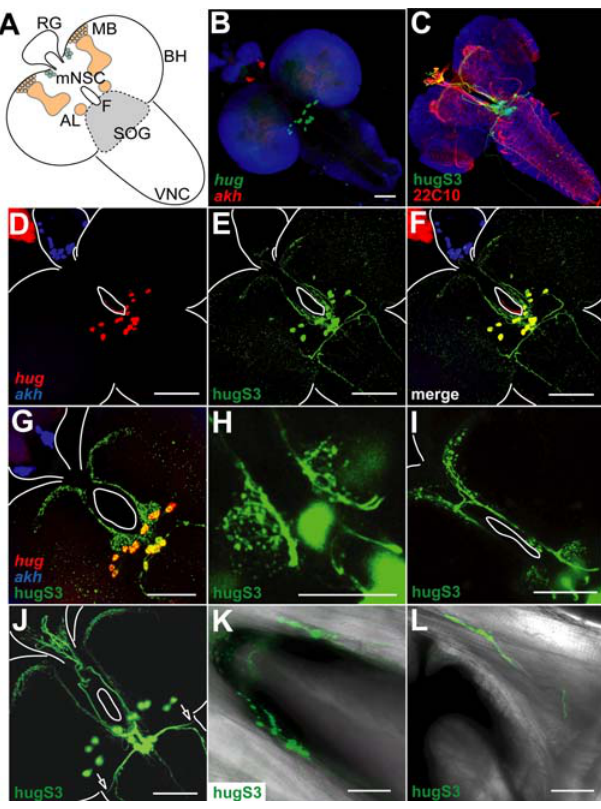
Figure 2. Neuroanatomical Analysis of hug Expression and Neuronal Projection Patterns in Larvae (A) A schematic drawing of the Drosophila larval CNS, showing the relative positions of the two brain hemispheres (BH) and the VNC, with the neuroendocrine ring gland (RG) located dorsoanterior to the CNS. The esophagus goes through the brain, and we have termed the hole through which the esophagus passes as the foramen (F). Positions of the SOG, the larval antennal lobes (AL), the mushroom bodies (MB), and the median neurosecretory cells (mNSC) are depicted. (B) hug expression (shown in green) is restricted to the SOG. adipokinetic hormone ( akh , shown in red) serves as a ring gland marker; the CNS is false-colored in blue. (C) Detection of marker gene expression under hug promoter-Gal4 (hugS3) construct (shown in green) labels hug cell bodies and neuronal projections relative to the neuropil (22C10, shown in red) and nuclei of post-mitotic neurons (elav, shown in blue). (D–F) The endogenous hug expression pattern (shown in red in [D]) is reproduced by the hugS3 expression pattern (shown in [E]). Note double-positive cell bodies in (F). akh serves as ring gland marker; CNS, ring gland, and foramen are outlined. (G and H) Immunofluorescent (G) as well as direct (H) detection of GFP expressed under the hug promoter-Ga14 construct reveals putative hug dendrites dorsoanterior of the hug cell bodies, where spherical structures are innervated. The hug cell bodies in the depicted blow-up of SOG region are out of focus in (H). (I) hug axons innervating the protocerebrum cross the midline, showing ipsilateral and contralateral innervation of mushroom body region. (J–L) Expression of eGFP under hugS3 shows hug axons leaving the SOG laterally (see arrows). These can be followed to the cephalopharyngeal complex of the larvae (K and L) onto the pharyngeal muscles (axons shown in green overlayed with trans- mission light picture; note the mouth hook apparatus in black). Dorsal (K) and lateral views (L) are shown, anterior points to upper left corner. All fluorescence images in this and subsequent figures are Z-stack projections, and all scales bars are 50 l m, unless otherwise